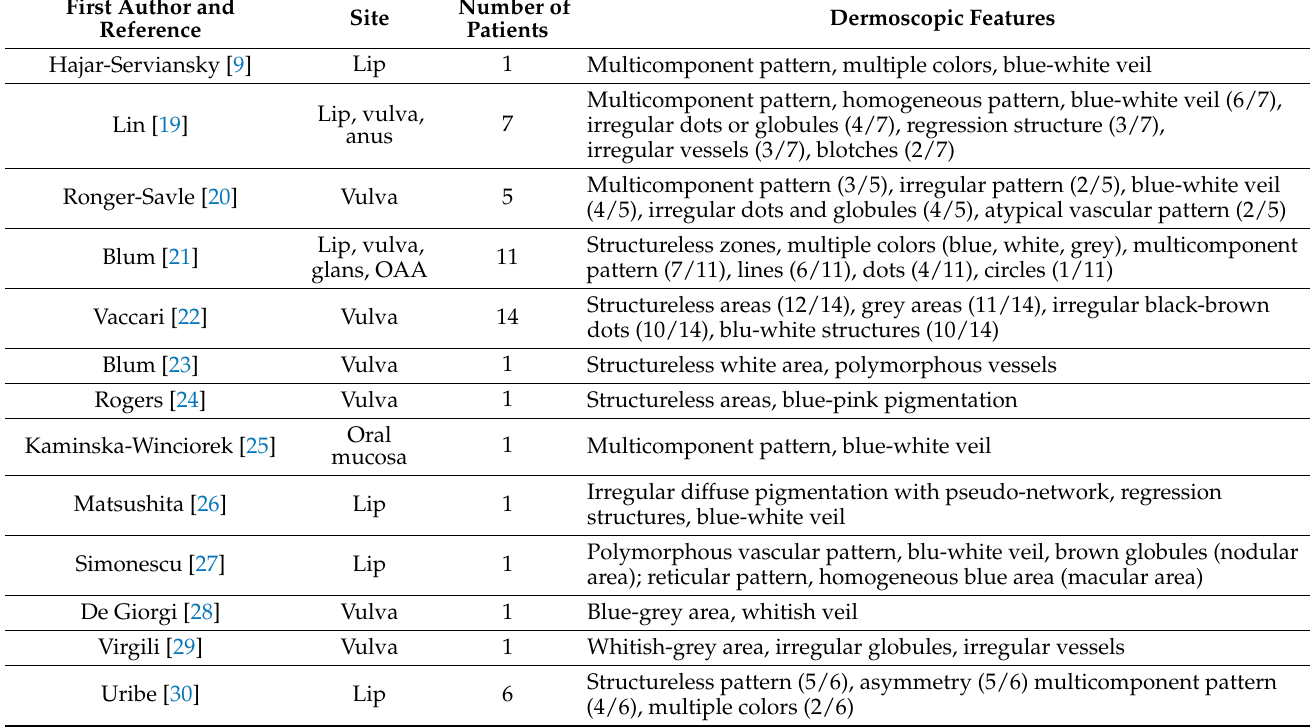
Table 1. Dermoscopic features of the mucosal melanomas reported in the literature.